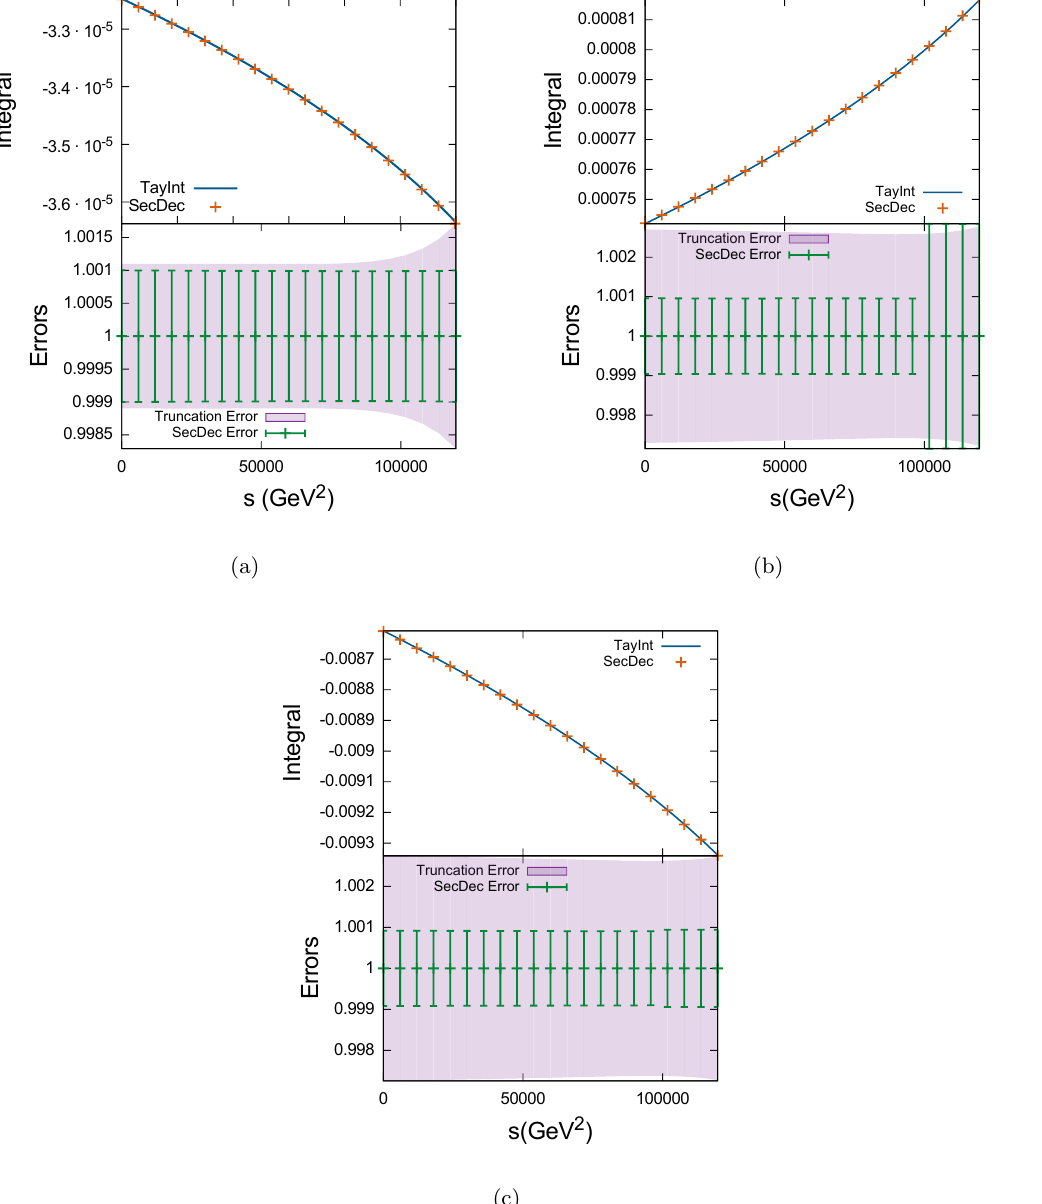
Figure 13 . I39 below threshold, calculated with a sixth-order series expansion at; (a) O ( (cid:15) 0 ), (b) O ( (cid:15) 1 ), (c) O ( (cid:15) 2 ) with u = (cid:0) 59858 GeV 2 , m 2 = 1 p m 1 and m 1 = 173 GeV. The lower plots show 2 the relative uncertainties of the TayInt and numerical SecDec results,